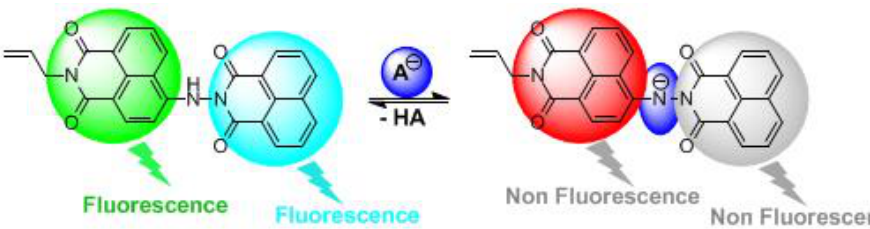
Figure 4. ( A ) Fluorescence of sensor 5 at different pH ( λ EX = 340 nm) and ( B ) titration plot of 5 at λ F = 504 nm in a pH range of 7 – 14 ( λ EX = 340 nm).